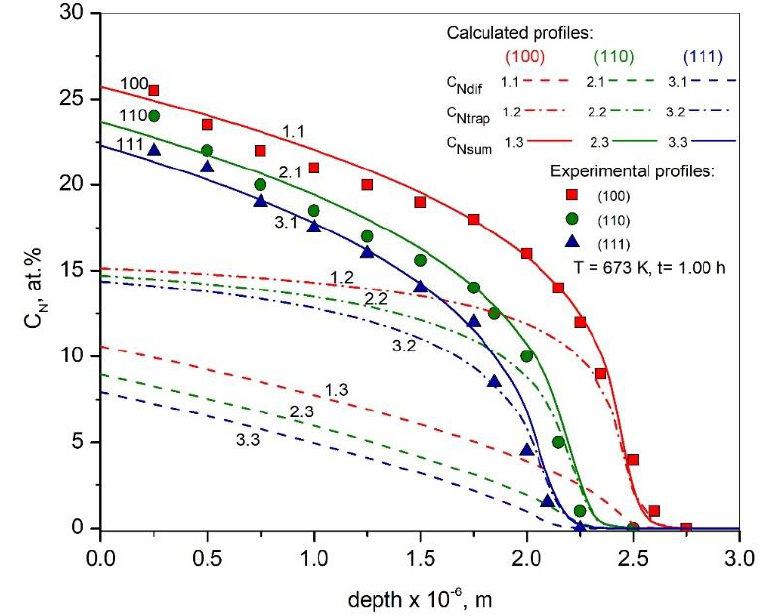
Figure 1. Calculated (lines) and experimental (points) (data from [19]) depth profiles of nitrogen: solid lines 1.1–3.1 resulting nitrogen profiles in the (100), (110) and (111) oriented single crystals of ASS, dotted lines 1.2–3.2 nitrogen in trap sites and dotted lines 1.3–3.3 diffusing nitrogen. Nitriding temperature 673 K.